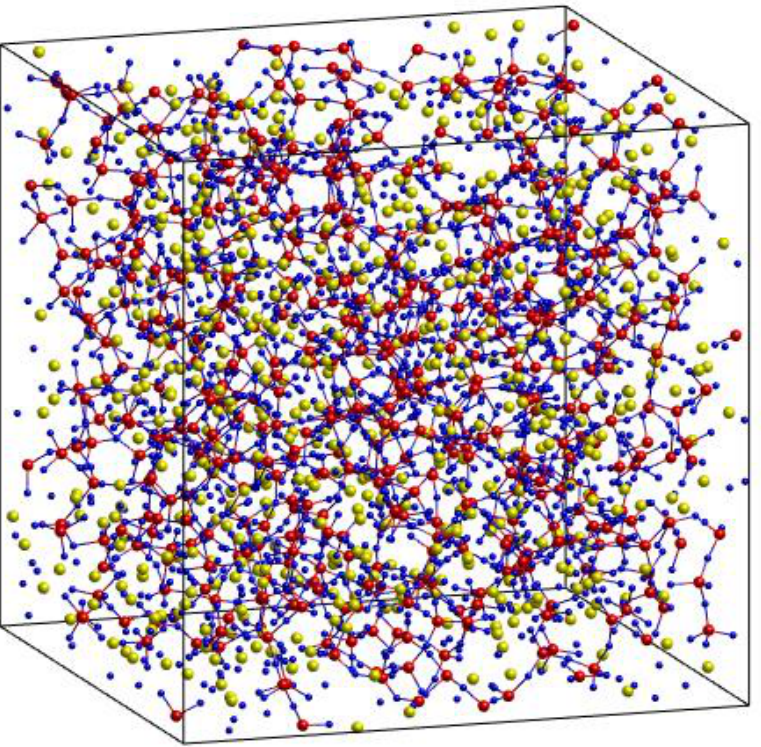
Figure 2. Snapshots of the atomic arrangement of AS2 model at ambient pressure, the temperature of 600 K. Here Si, Al, and O atoms are in red, yellow, and blue color, respectively